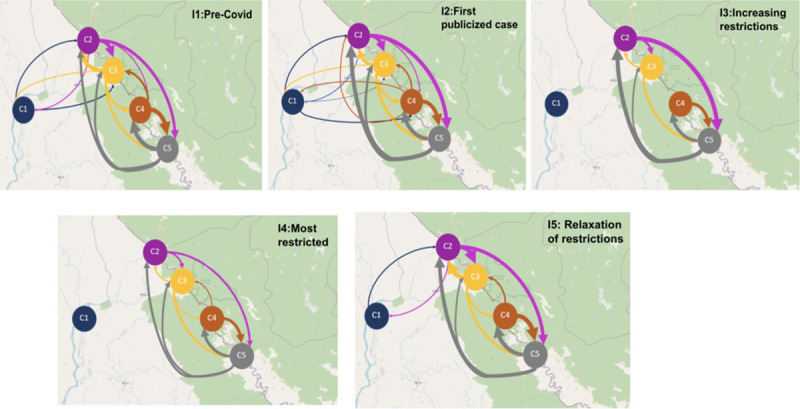
Human mobility network visualization for Intervals 1–5.Each node represents an activity cluster. Each edge denotes human movement in the direction of the arrow. The thickness of the edges is proportional to the number of trips between the nodes. Cluster C1 corresponds to a small town in Myanmar; C2 corresponds to village A, C3 corresponds to village B; C4 covers villages C and D; and C5 corresponds to the district capital. The maps in this figure were created using an open-source map from https://landsatlook.usgs.gov/.